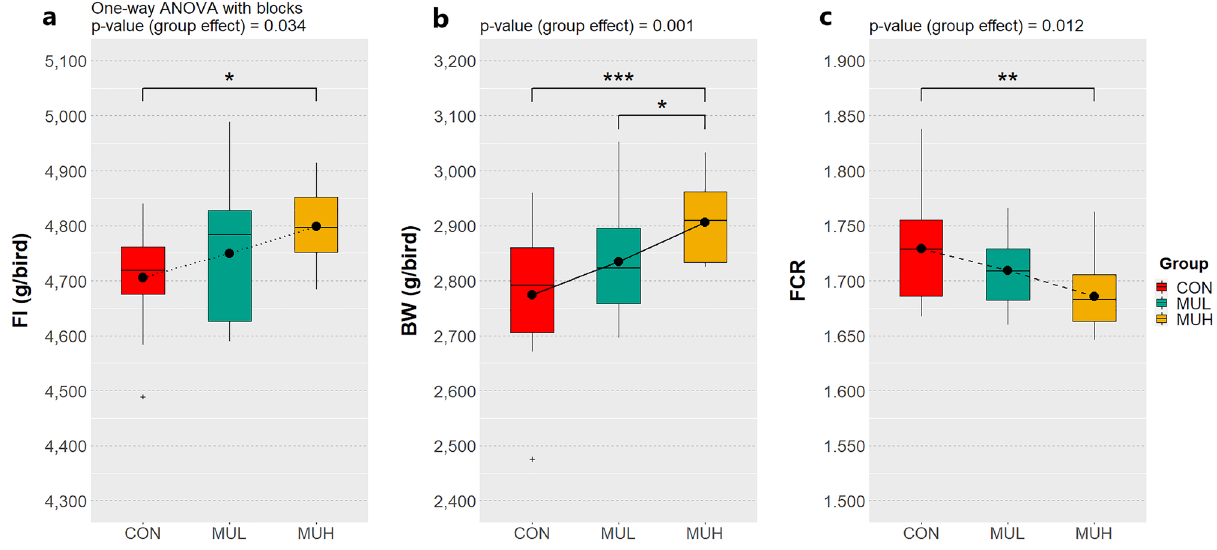
Figure 1. Cumulative FI ( a ), BW ( b ), and FCR ( c ) of CON, MUL, and MUH (0–42 d). FI, BW, and FCR were measured on 12 replicates per group arranged in a randomized complete block design. Group means are drawn as black dots inside the boxes. * p -value ≤ 0.05; ** p -value < 0.01; *** p -value < 0.001. Linear trends are drawn as black lines connecting the group means (dotted line, p -value < 0.05; dashed line, p -value < 0.01; solid line, p -value < 0.001).